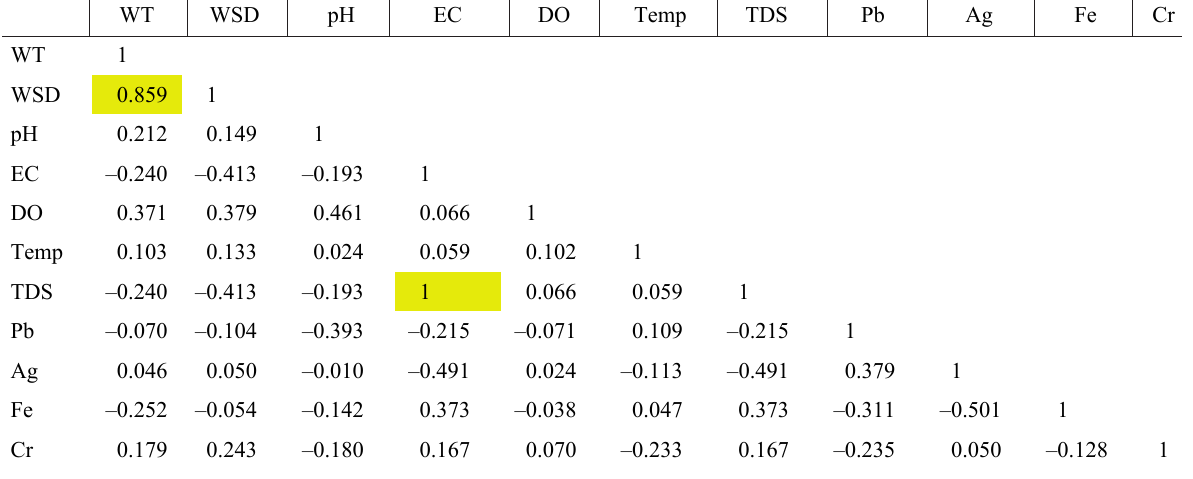
Table 3. Correlation matrix of BH water parameters in the study area, high correlations are shown in yellow